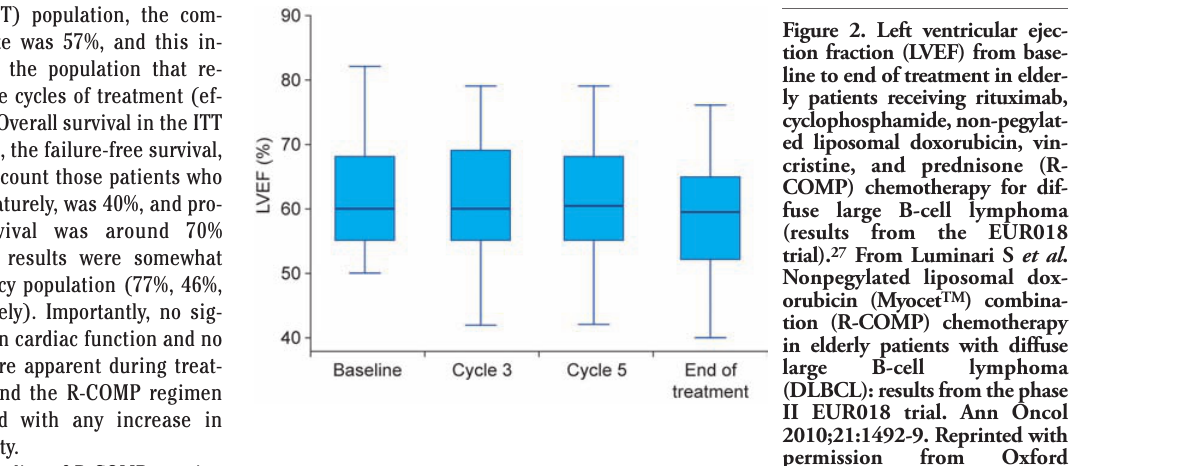
Figure 1. Kaplan-Meier analysis of the probability of (A) overall survival, (B) failure-free survival, and (C) progression-free survival in elderly patients receiving rituximab, cyclophosphamide, non-pegylated liposomal doxorubicin, vincristine, and prednisone (R-COMP) chemotherapy for diffuse large B-cell lymphoma (results from the EUR018 trial). 27 From Luminari S et al . Nonpegylated liposomal dox- orubicin (Myocet TM ) combination (R-COMP) chemotherapy in elderly patients with diffuse large B-cell lymphoma (DLBCL): results from the phase II EUR018 trial. Ann Oncol 2010;21:1492-9. Reprinted with permission from Oxford University Press.